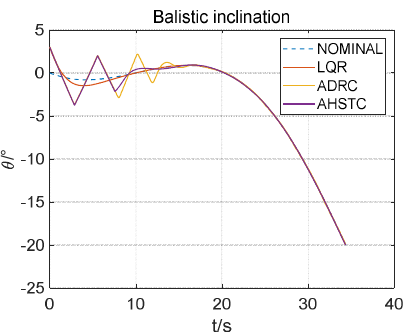
Figure 8. Tracking curve of trajectory inclination angle θ .